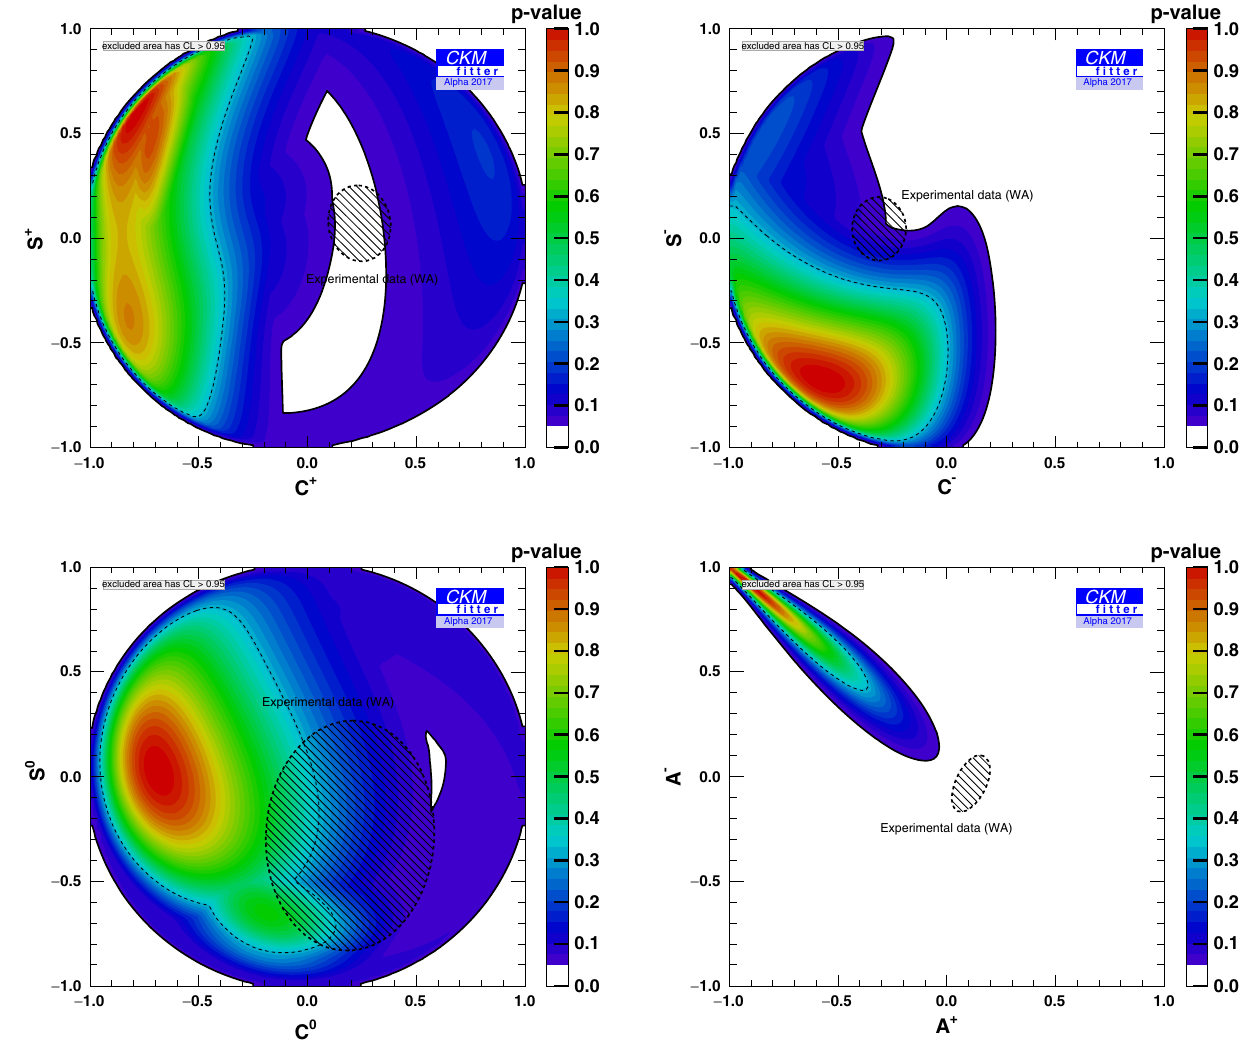
Fig. 33 Two-dimensional constraints on the flavour-dependent, ( C i , S i ) i =+ , 0 , − , and flavour-independent ( A + , A − ) asymmetries. In each case, the experimental value derived from the related U or I coefficients and not included in the fit is indicated as a shaded